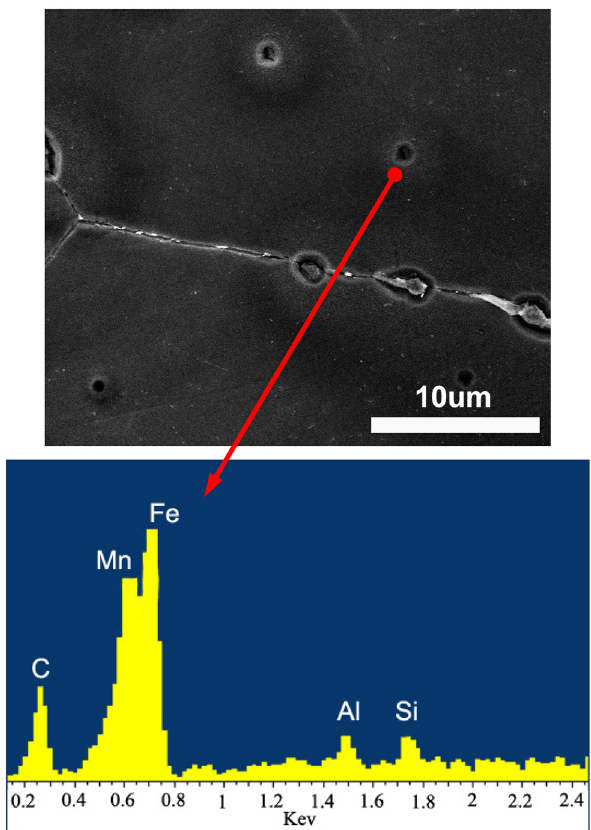
Figure 9: SEM microstructure of TWIP steel matrix and EDS analysis results of